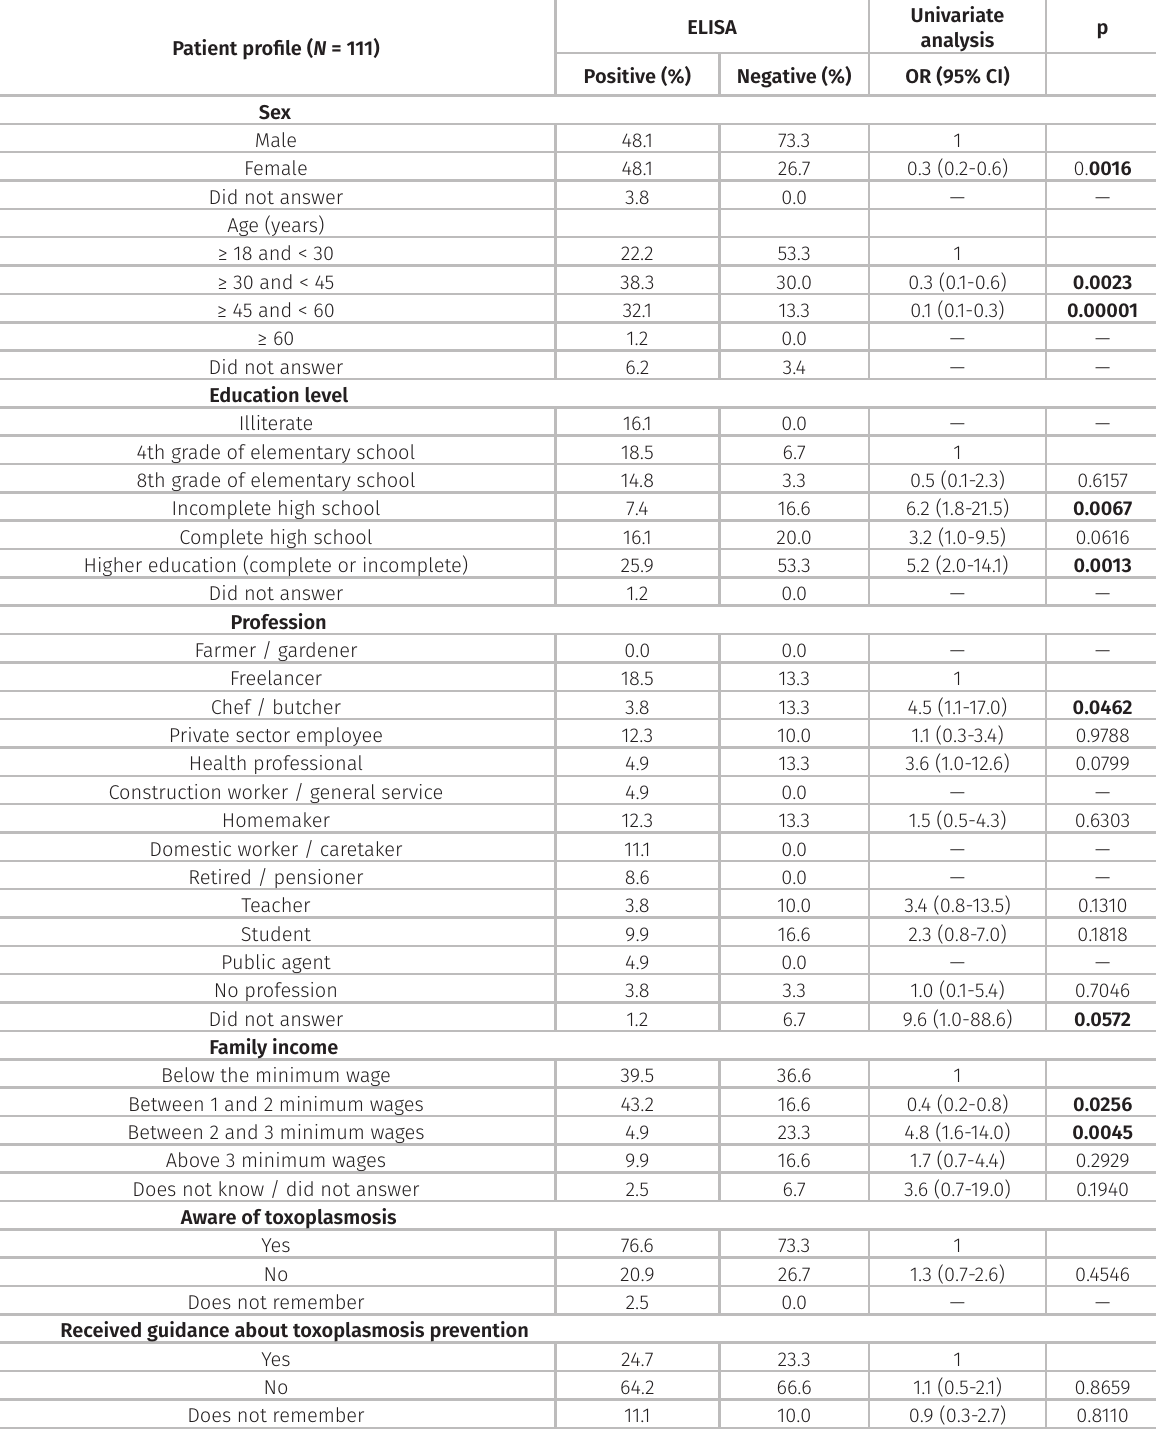
Table I. Univariate analysis of HIV/AIDS patients attended by the Expert Assistance Service of Foz do Iguaçu city, Paraná state, Brazil, in